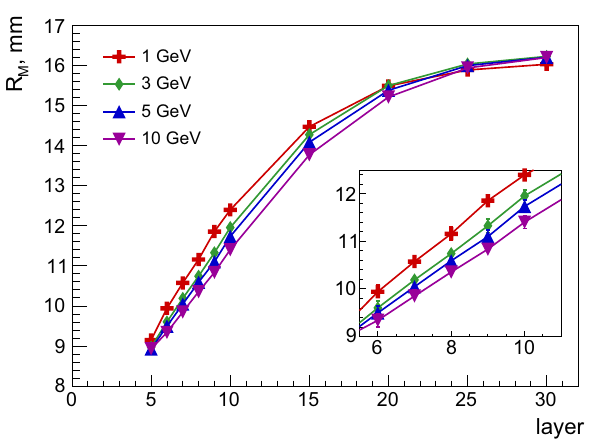
Fig. 27 RMS of the lateral deposited energy distributions in detector layers obtained in simulation, for different electron beam energies